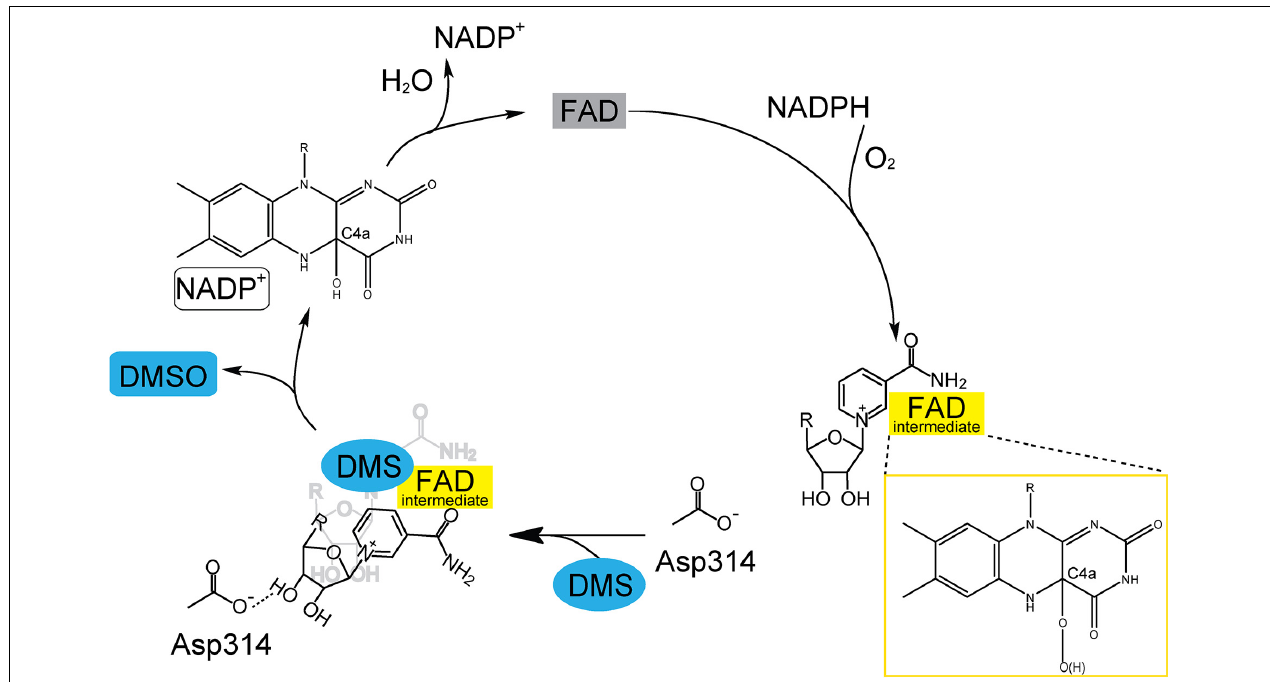
FIGURE 5 | A proposed catalytic cycle of Tmm 7211 oxidizing DMS to generate DMSO. In the reductive half-reaction, FAD is reduced by NADPH. In the oxidative half-reaction, the reduced FAD reacts with O 2 , and a C4a-(hydro)peroxyflavin (FAD intermediate) is formed. The nicotinamide ring of NADP + protects the FAD intermediate from solvent attack. When DMS enters the catalytic pocket, NADP + generates a conformational change to form a hydrogen bond with Asp314, shutting off the substrate entrance and exposing the FAD intermediate to DMS. After the reaction, DMSO, NADP + and a water molecule are released and the oxidized FAD is